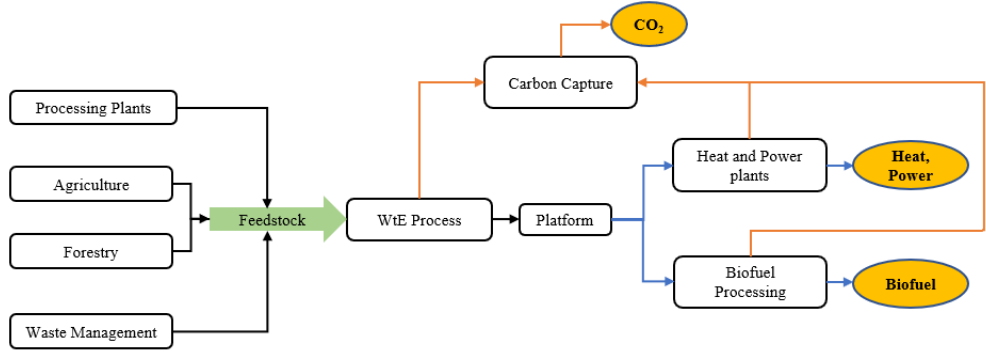
Figure 11. Biorefinery integration with downstream processes.